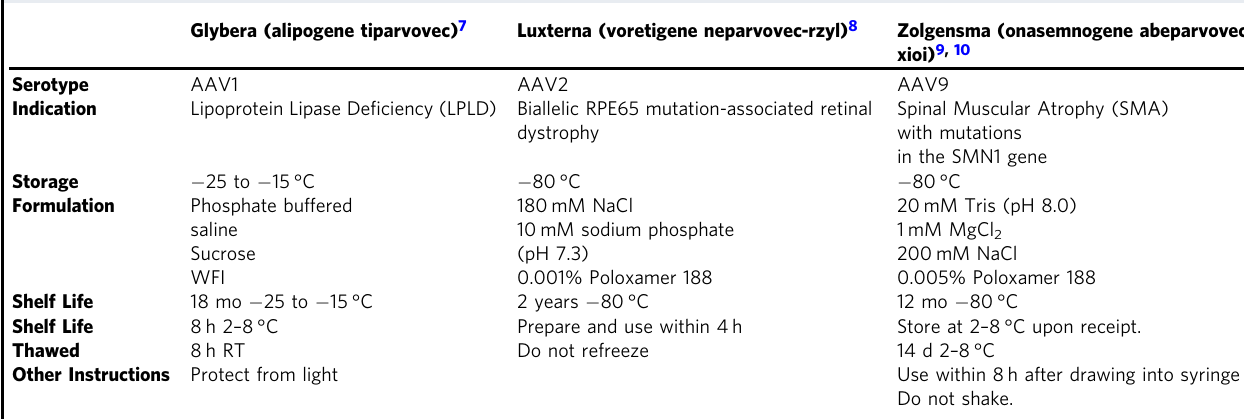
Table 1 Stability pro fi les of current (or formerly) marketed AAV poducts 7 – 10